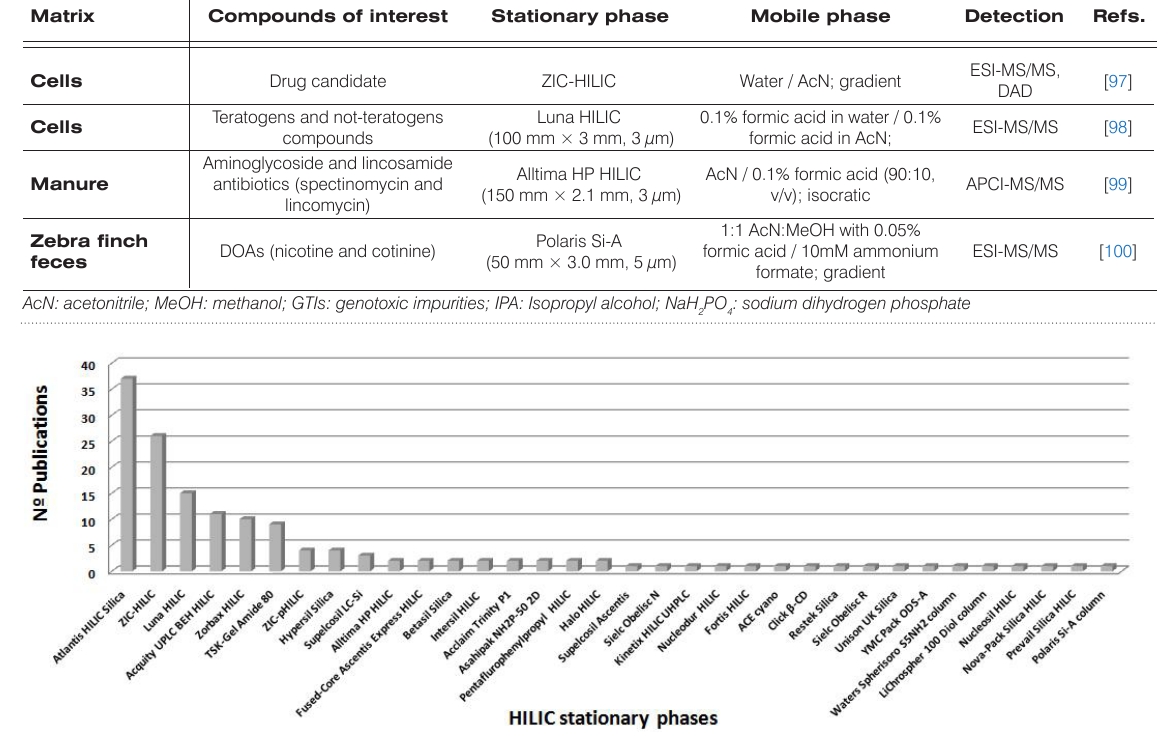
Figure 3. HILIC stationary phases used in pharmaceutical